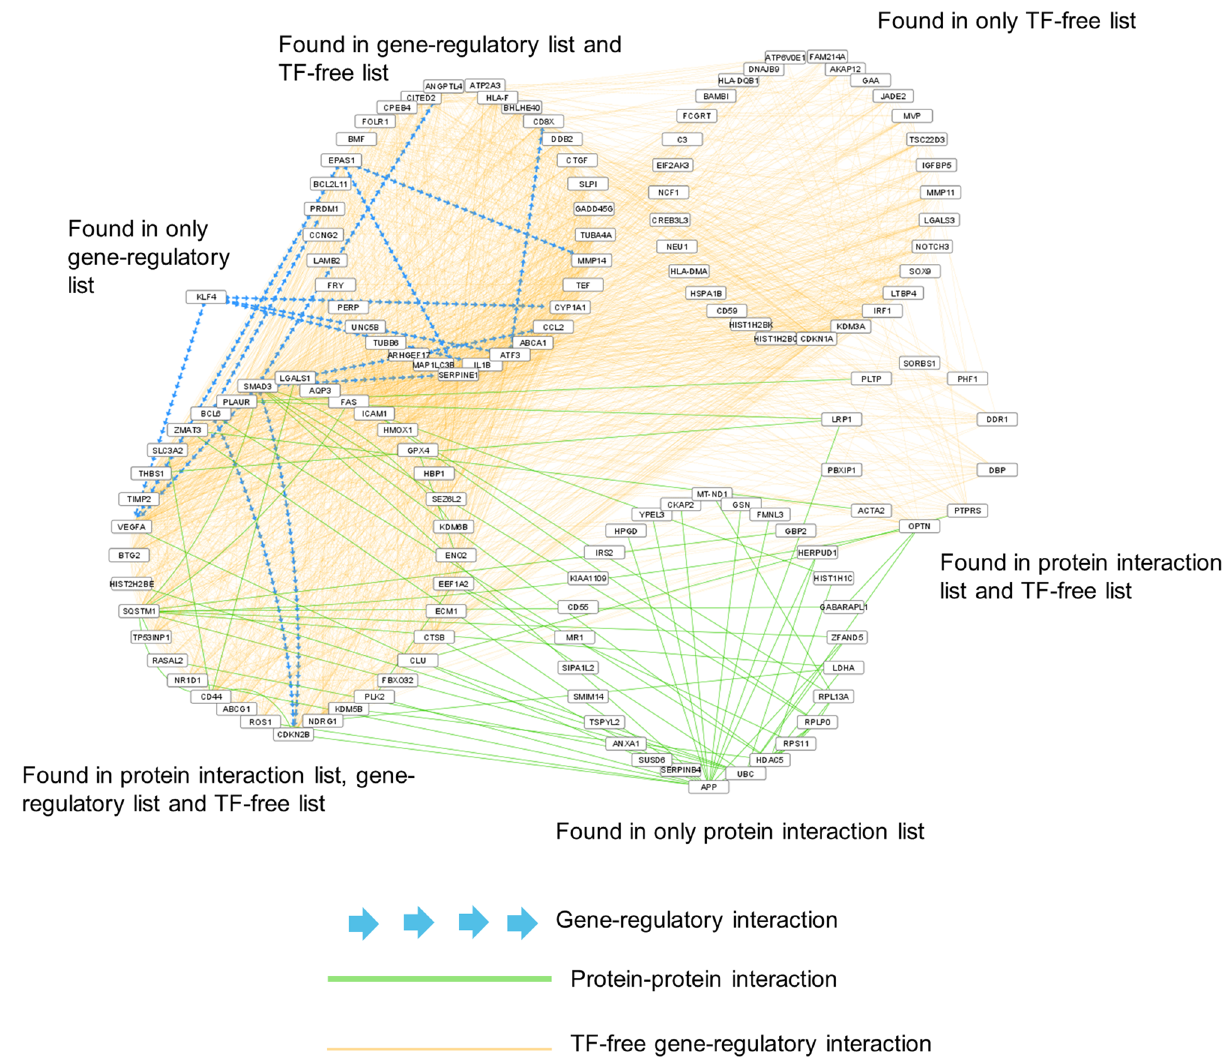
Figure 2. Dormancy-interaction network. The network was constructed by integrative analysis of all subnetworks. Dormancy-interaction network includes genes found in different subnetwork analyses (shown in different clusters). Gene regulatory interactions between genes are shown by blue arrows, the direction of the arrow represents the direction of the interaction. Protein–protein interactions are shown by green lines and TF-free gene-regulatory interactions by orange